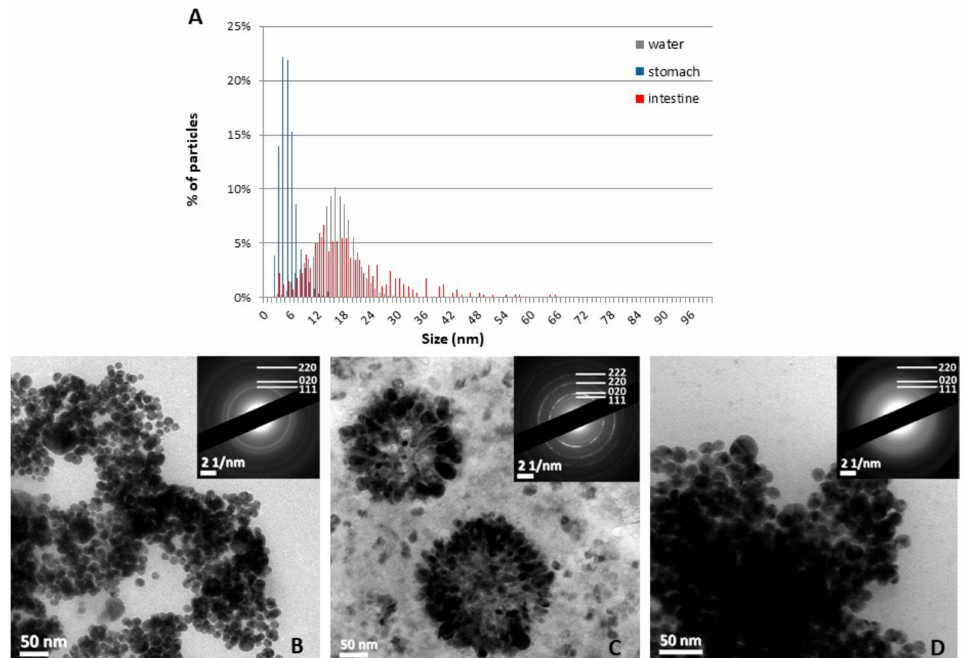
Figure 1. ( A ) Size distribution analysis by transmission electron microscopy (TEM) of undigested silver nanoparticles (Ag NPs) in water (grey); digested in stomach (dark blue); digested in intestine (red) where at least 500 particles for each TEM specimen were analysed by Image J (see method for details). Size: 18 nm ± 5 nm in the water; 5 nm ± 2 nm in the stomach and 17 nm ± 11 nm in the intestine compartments. Bright field TEM images showing silver nanoparticles (AgNPs) ( B ) and AgCl NPs ( C ) found in the stomach after simulated ingestion of AgNPs. Each inset shows the selected area electron diffraction (SAED pattern) acquired from the ROI indicating Ag and AgCl Miller indices (Ag PDF number 01-089-3722 4-783; AgCl PDF number 01-071-5209 31-1238). ( D ) Bright field TEM image and relative SAED pattern acquired from the intestine compartment after simulated ingestion of AgNPs. Consistent with B (Ctrl), the Miller indices correspond to a metallic Ag crystal